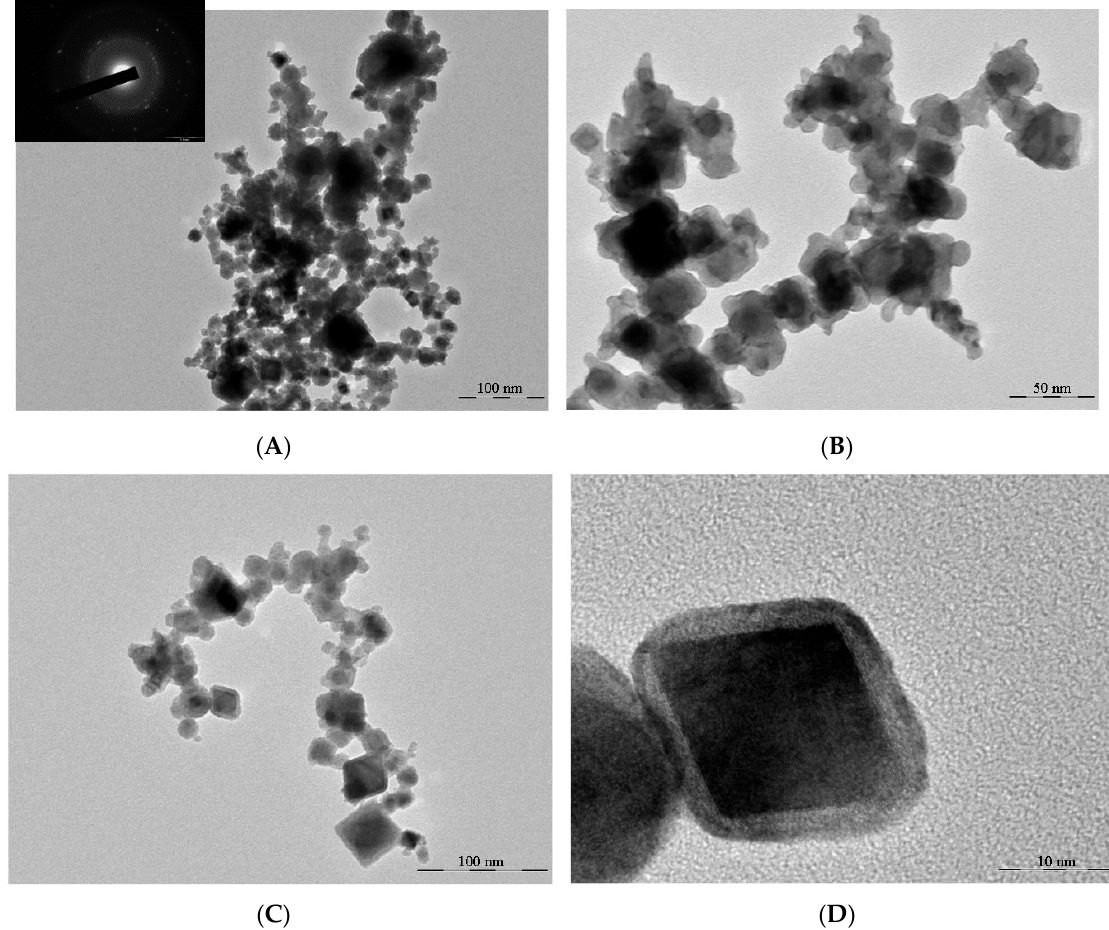
Figure 4. Transmission electron microscopy (TEM) images of nanoparticles at different magnifications ( A – D ) and the electron diffraction pattern (inset of ( A )).